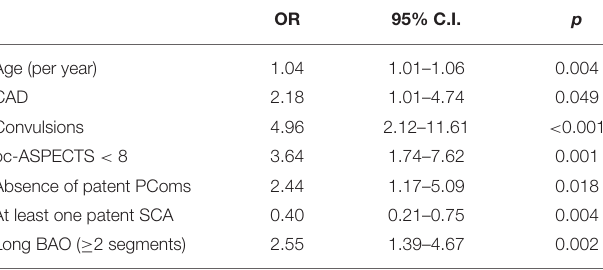
TABLE 2 | Factors associated with acute coma in BAO patients. OR 95% C.I.